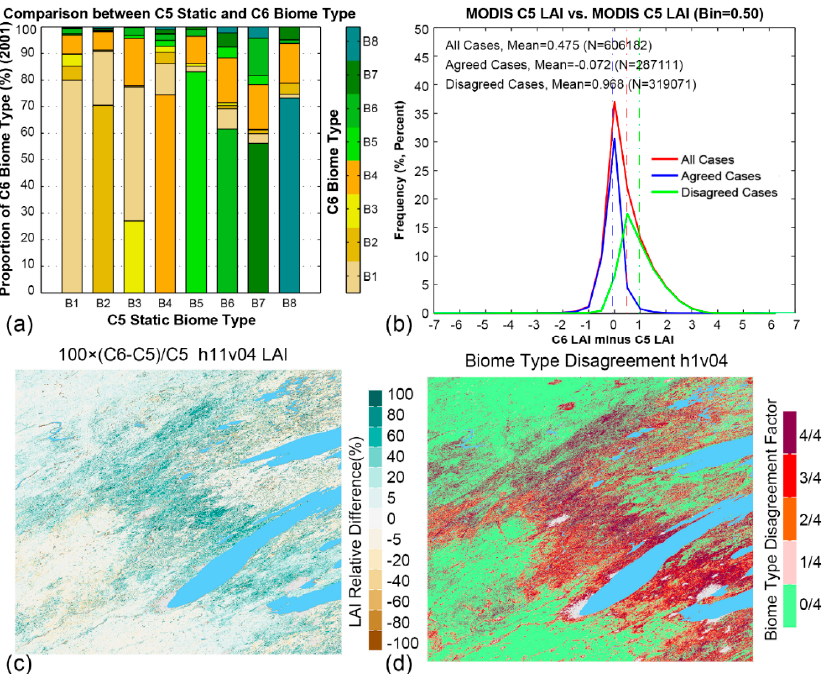
Figure 6. Impact of input biome map change on LAI/FPAR retrievals. ( a ) Areal proportion of globally changed biome type from static C5 to dynamic C6 input biome type (2001–2003). Proportions of C6